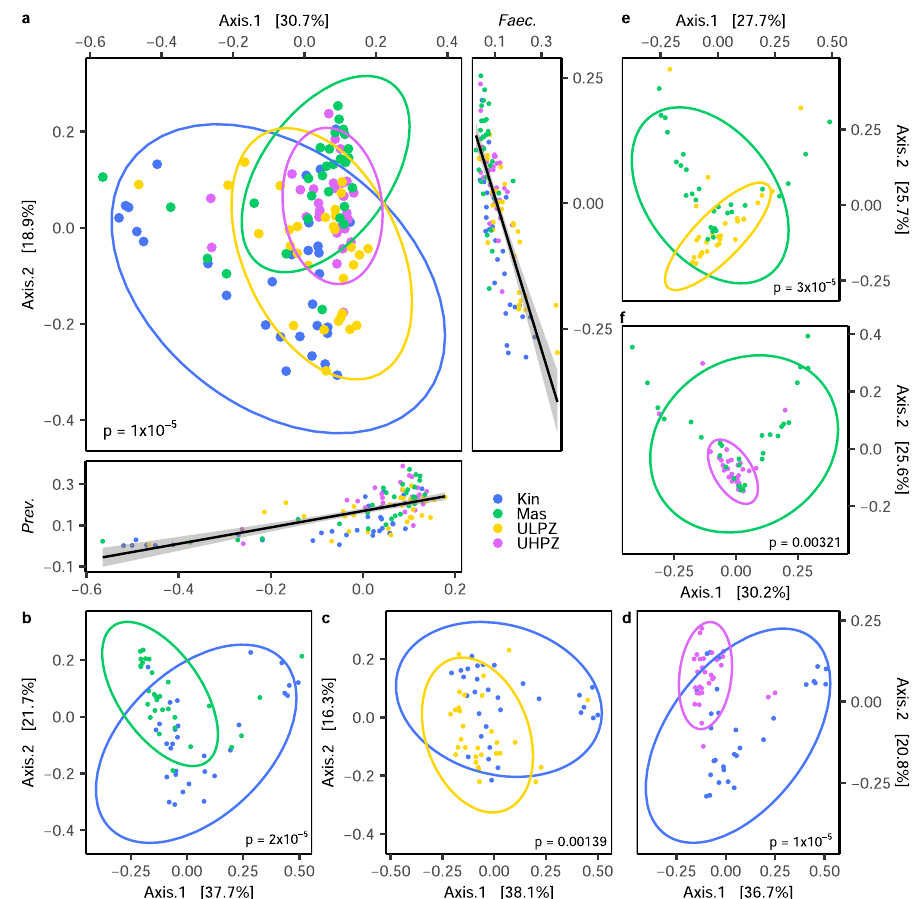
Fig. 3 Global measure of gut bacteria dissimilarity at the genus level for a geographic context. PCoA representations based on Bray-Curtis dissimilarity matrix values at the genus taxonomic level for a Kinshasa (Kin) vs. Masi-Manimba (Mas) and unaffected children from the low prevalence zone (ULPZ) and high prevalence zone (UHPZ) of Kahemba combined, b Kinshasa vs. Masi-Manimba, c Kinshasa vs. ULPZ, d Kinshasa vs. UHPZ, e Masi-Manimba vs. ULPZ, and f Masi-Manimba vs. UHPZ. Correlations in a were generated using Spearman ’ s Correlation method of genus relative abundance against principal coordinate 1 and 2 axis values for each sample, and standard error with a 0.95 con fi dence interval is shown in gray with the regression line. Statistics for Bray-Curtis dissimilarity were generated using